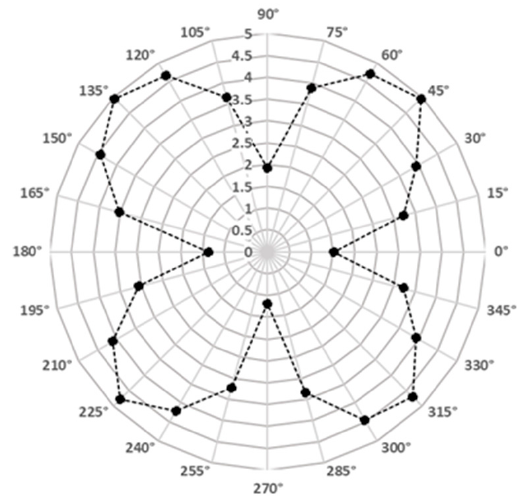
Figure 8. Relationship between tracking direction and the average scores obtained from the questionnaire. The higher the score, the more difficult the participants found the operation.